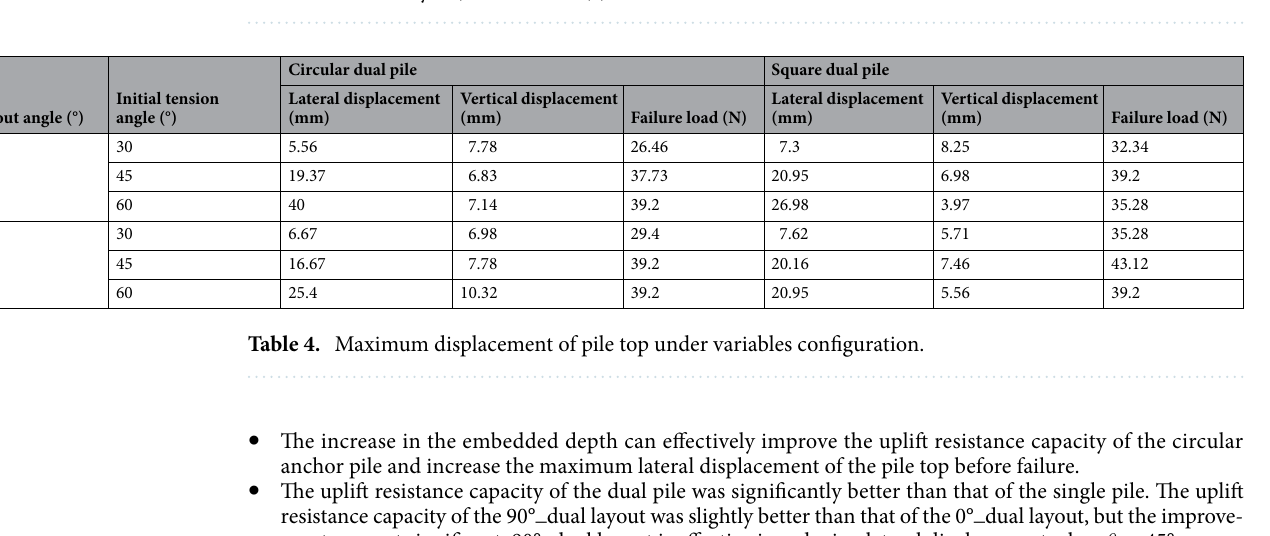
Figure 10. Different layouts of dual piles 0° _ dual ( a ) and 90° _ dual ( b ). Photos of the failure process of variables pile configuration (left column: circular single pile; middle column:circular 0° _ dual layout; right column: circular 90° _ dual layout) with θ = 60° ( c ).